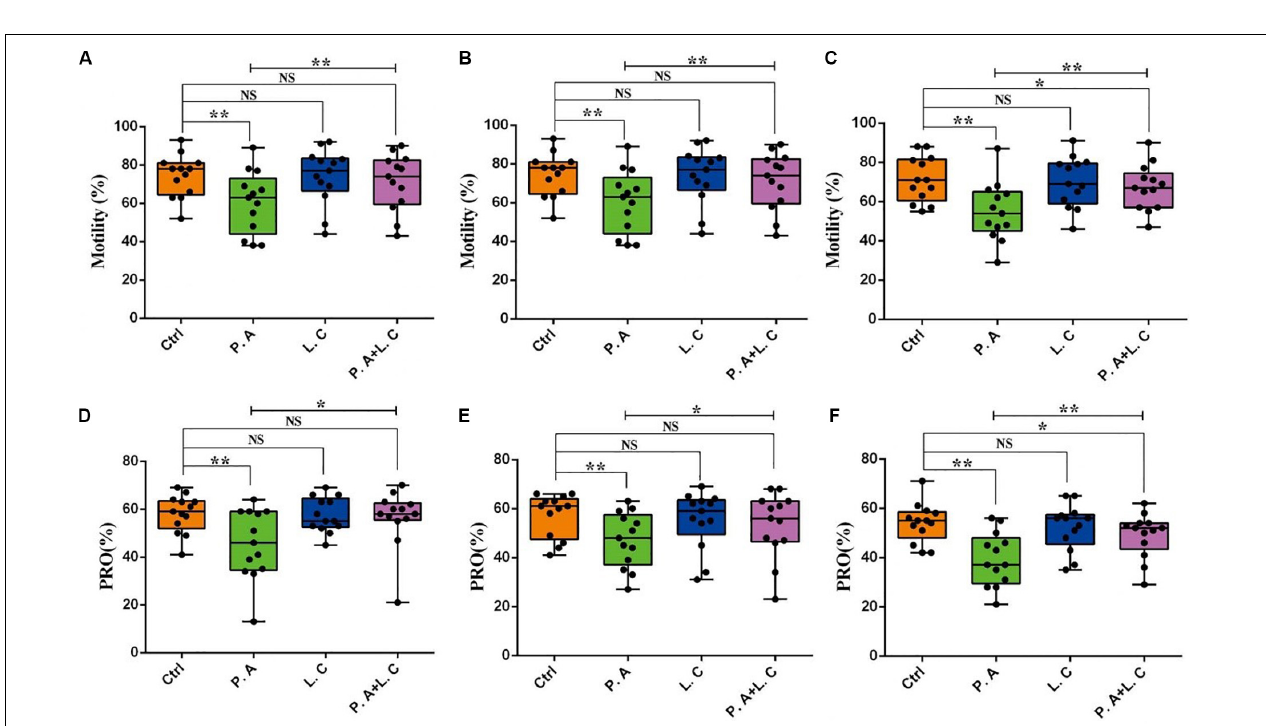
FIGURE 7 | Dominant bacteria impact on motility parameters of boar sperm in vitro preservation. Total motility was determined on Day 3 (A) , Day 5 (B) , and Day 7 (C) , as well as progressive motility on Day 3 (D) , Day 5 (E) , and Day 7 (F) . Ctrl, control group; P.A, Pseudomonas aeruginosa treatment group; L.C, Lactobacillus casei treatment group; P.A + L.C, Pseudomonas aeruginosa with Lactobacillus casei treatment group. As mean ± SEM, the * means significant differences ( P < 0.05), and the ** means highly significant differences ( P < 0.01) between treatments at the same day; NS means no significant differences ( P > 0.05). A total of 14 semen samples were used as biological